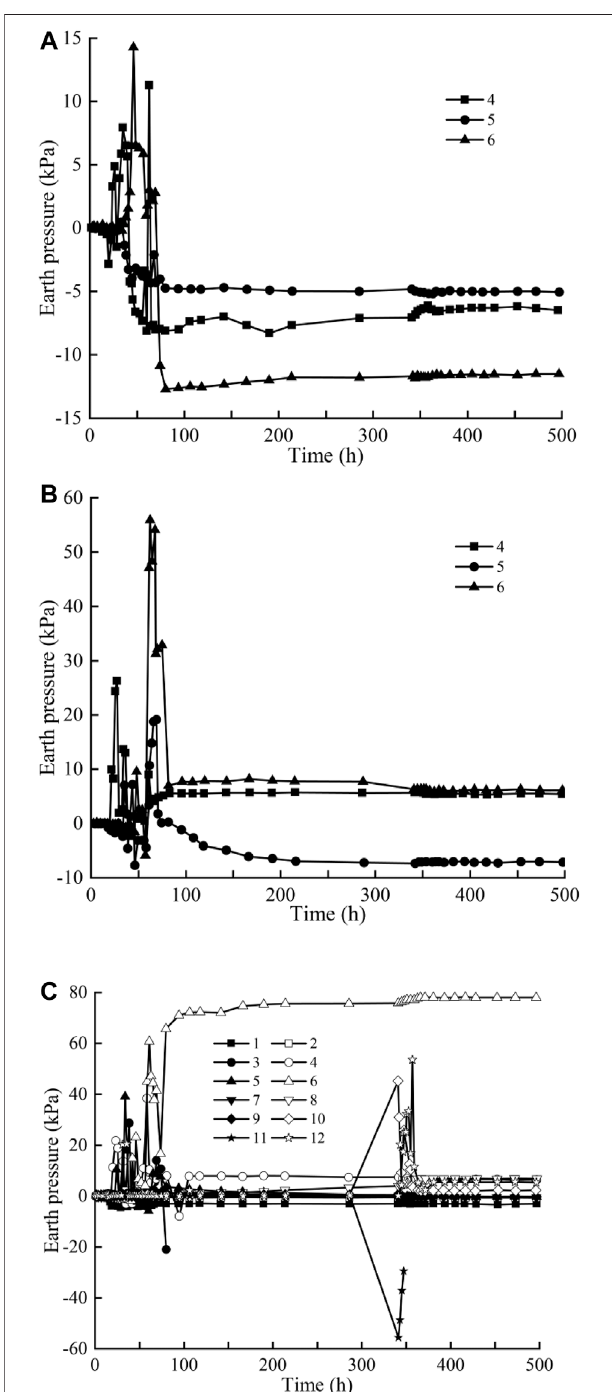
FIGURE 4 | Earth pressure with construction time along the direction of tunnel at different burial depths: (A) 6 m, (B) 8 m, and (C) 10 m.